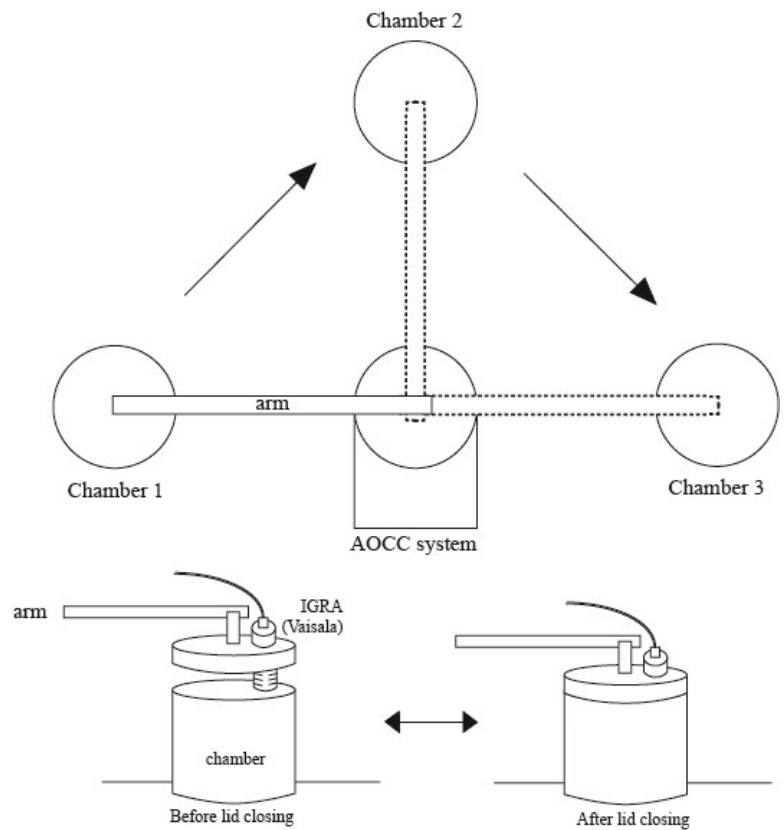
Figure 2. Automatic opening and closing chamber (AOCC) system for measurement of R s in three chambers. The lid connected to the arm of the AOCC system closed the chamber for a 5-min interval. The arm rotated from chamber 1 to chamber 2 to chamber 3. After measurement completion in chamber 3, the arm rotated back to chamber 1 for the next cycle. R s in a chamber was continuously